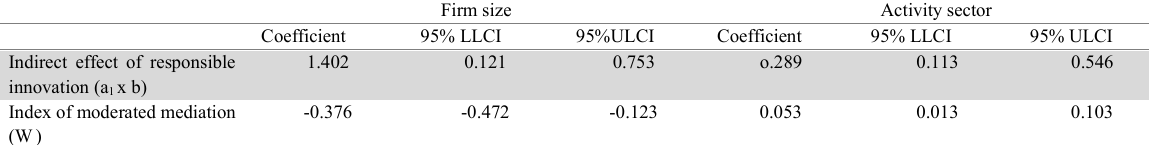
Conditional indirect effects of CSR strategy on competitive